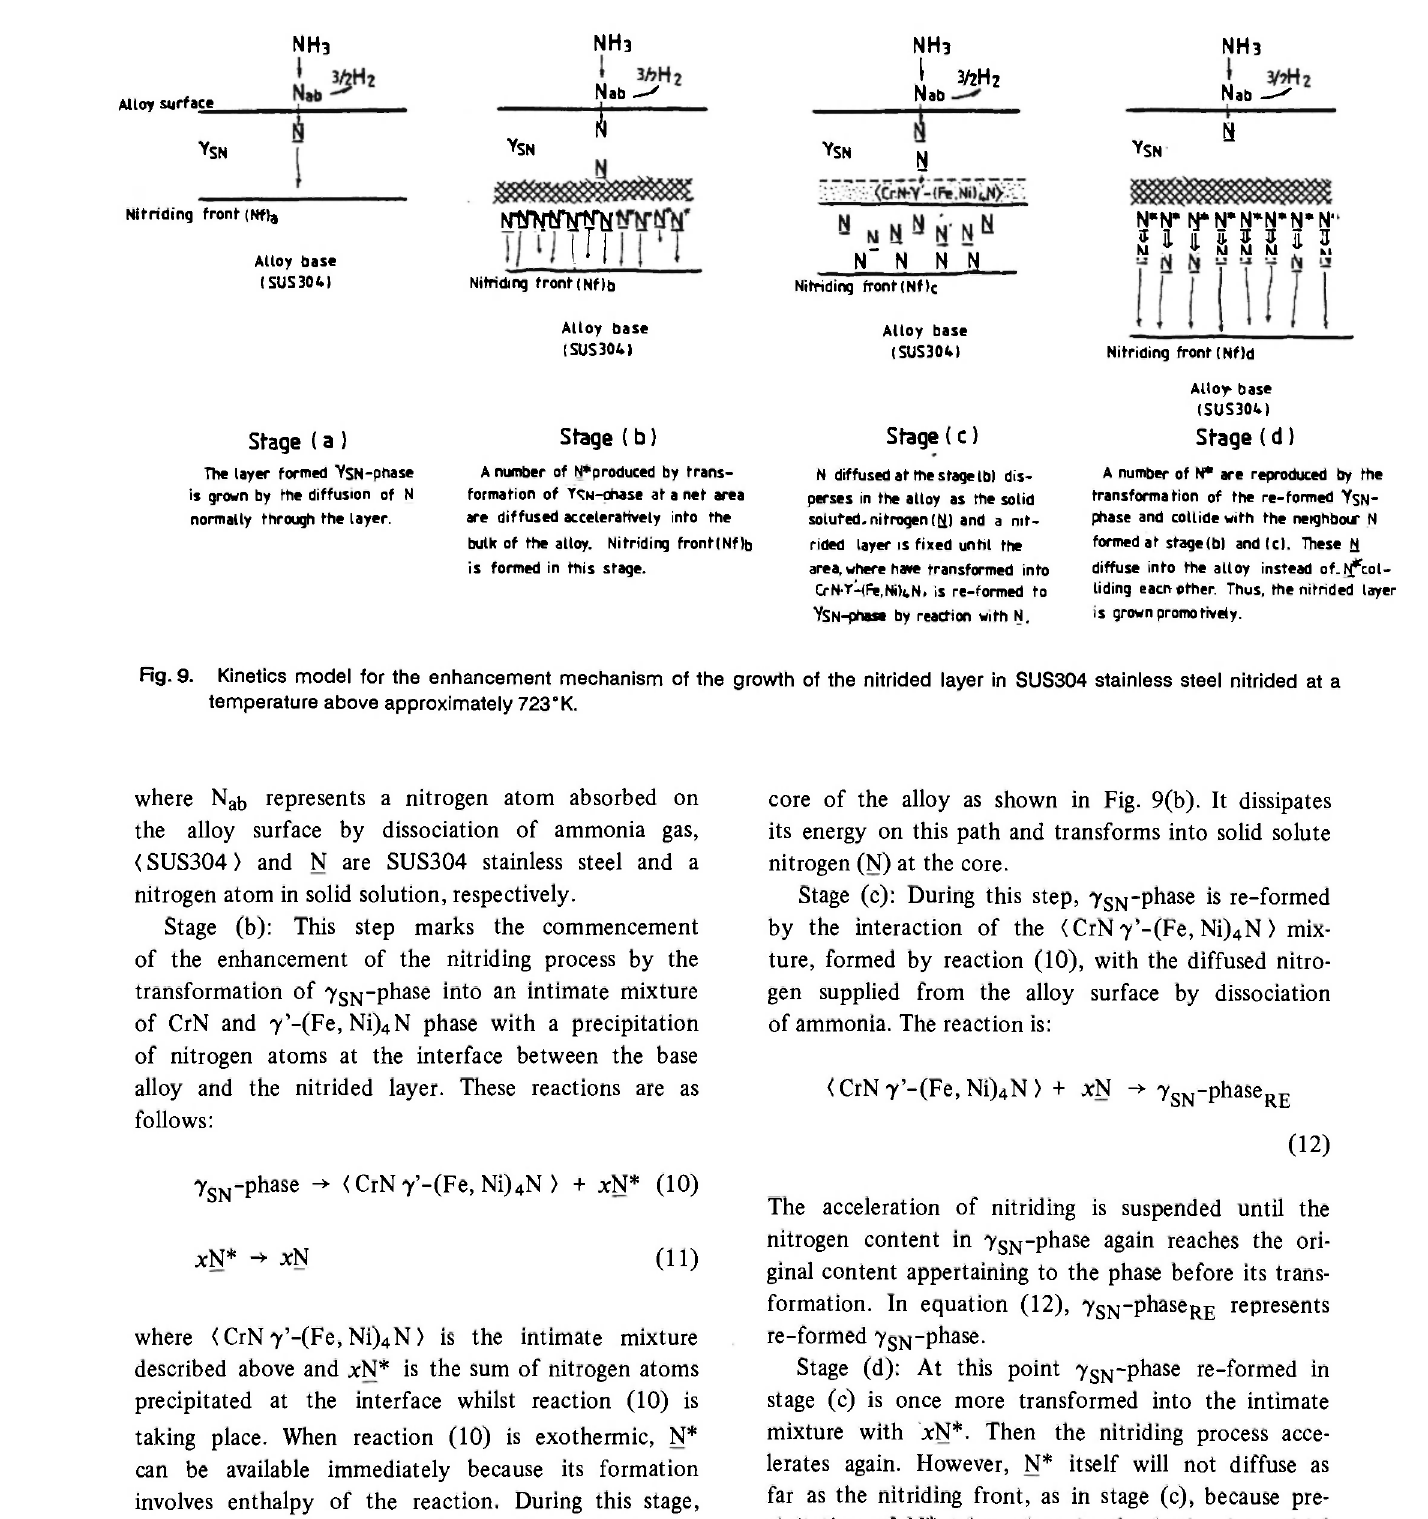
A number of N*produced by trans- formation of at a net area are diffused acceleratively into the bulk of the alloy. Nitriding frontlNflb is formed in this stage.